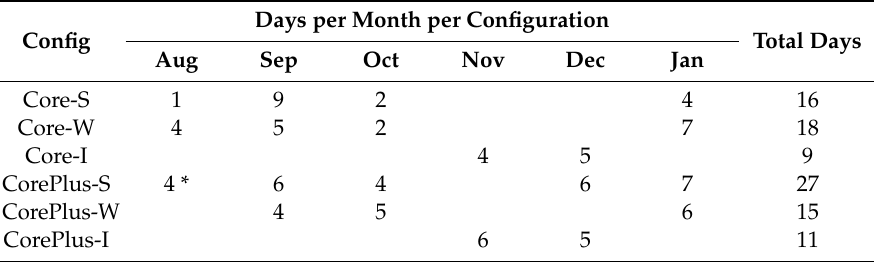
Table 4. Days of test data per configuration. This excludes days for which test facility had operational issues and the data were not